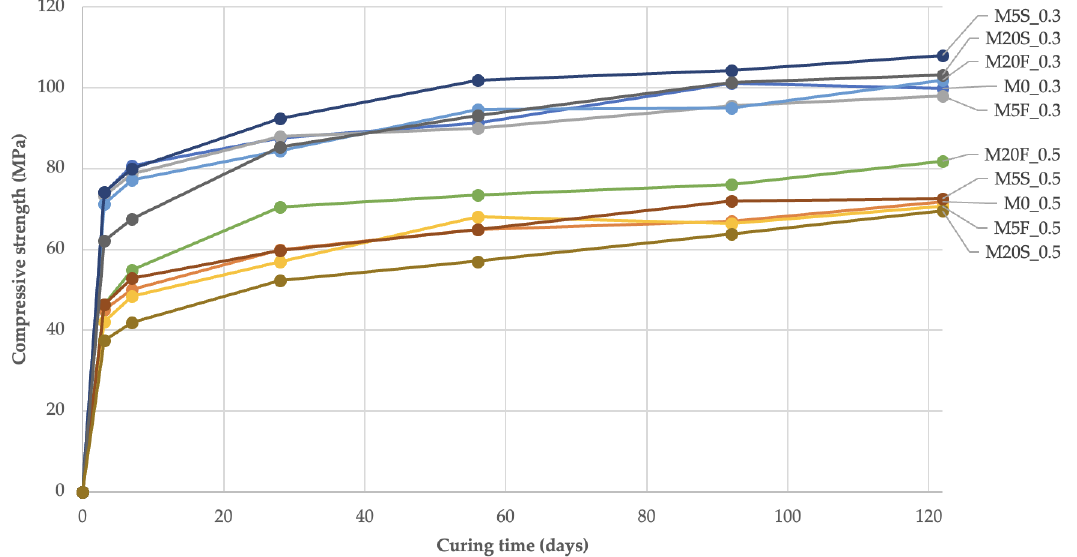
Figure 7. Graphs of changes in compressive strength of mortars over curing time.